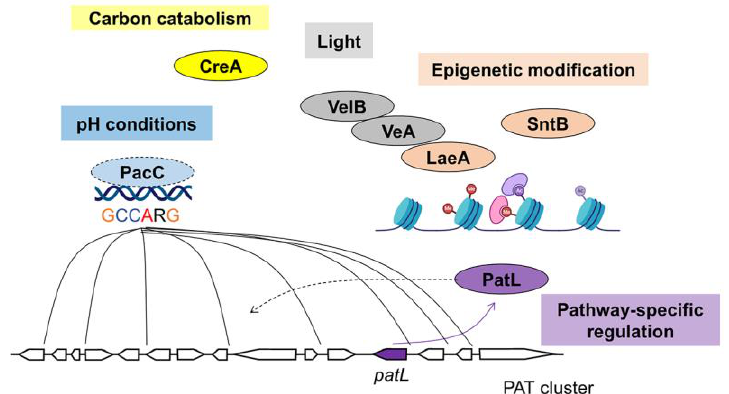
Figure 3. Regulatory mechanism of PAT biosynthesis.